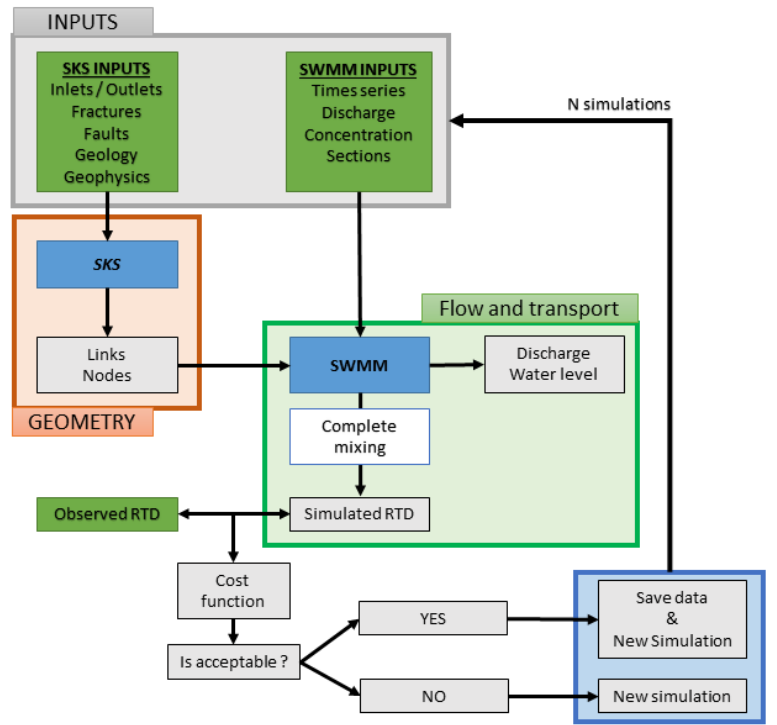
Figure 3. Coupling the Stochastic Karst Simulator (SKS) and Storm Water Management Model (SWMM) to solve the inverse problem based on artificial tracer tests. SKS is used to simulate the conduit network geometry and SWMM is used to simulate flow and solute transport, assuming an instantaneous complete mixing hypothesis.